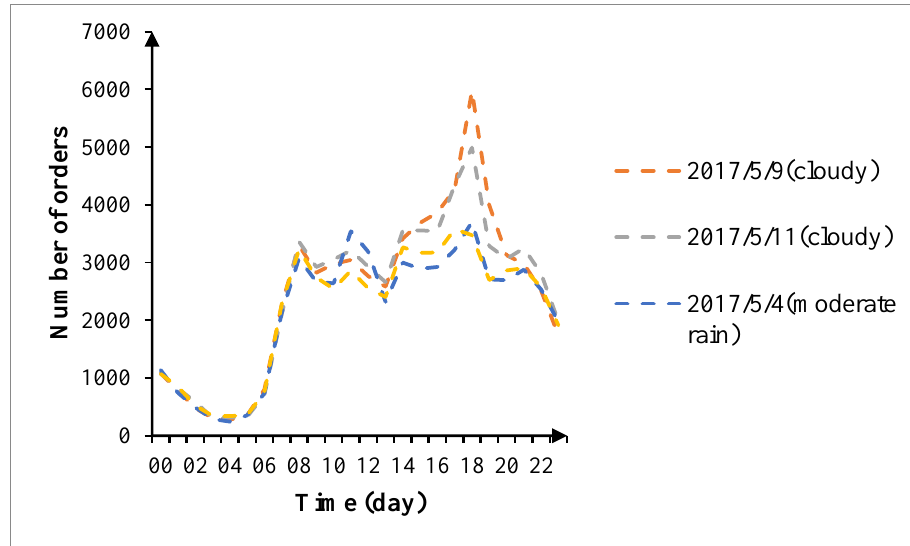
Figure 7. Relationship between demand of online car-hailing and weather.